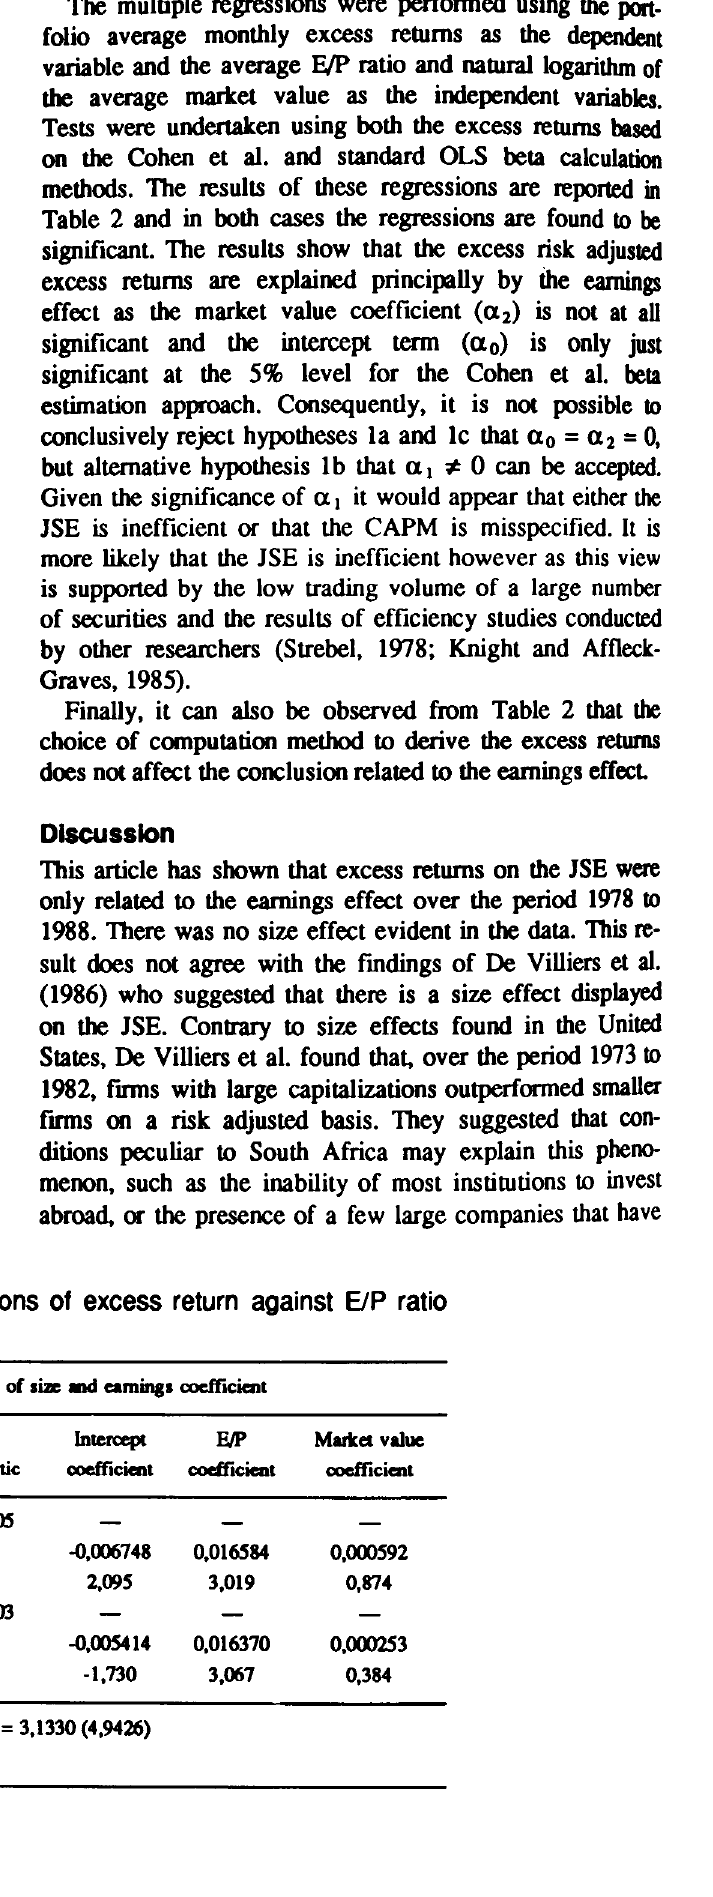
Figure 2 Graph of percentage difference between Cohen et al. and OLS betas as a function of portfolio size 1be firms with the largest market values are generally